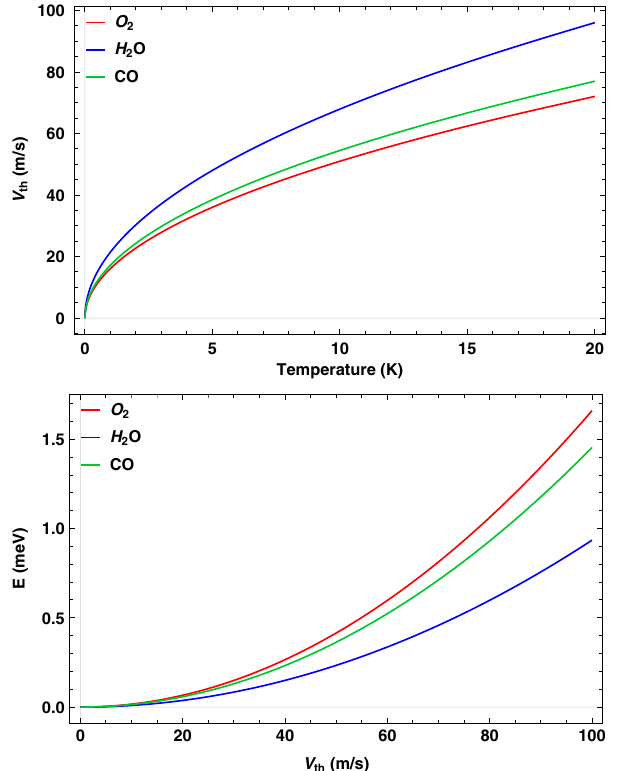
FIG. 4. The rms transverse thermal velocity of a molecule, v as a function of temperature (top) and the average kinetic energy versus the rms thermal velocity v The top panel of Fig. 4 represents the variation of v function of temperature. The bottom panel shows the kinetic energy E in units of meV as a function of v